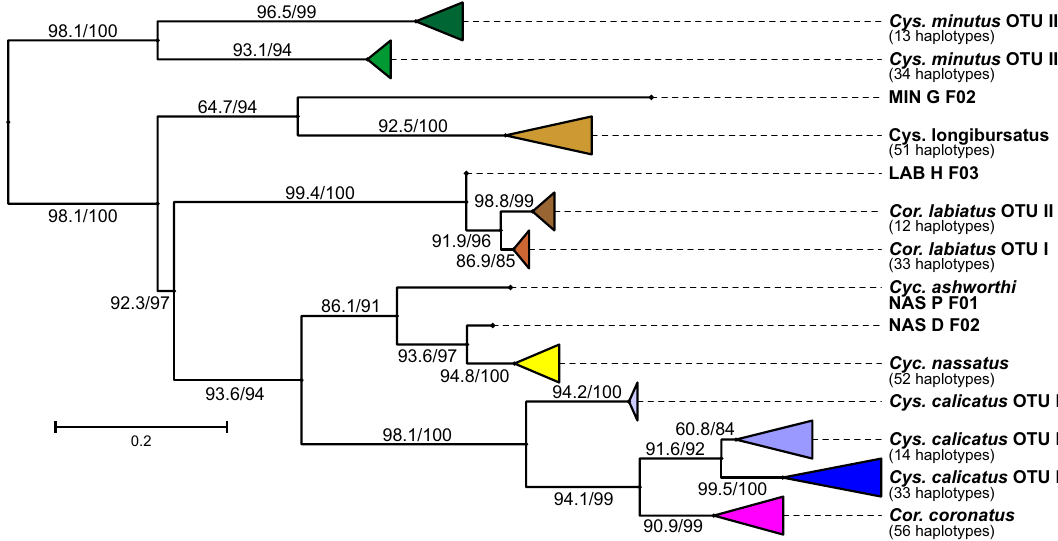
Figure 2. Maximum likelihood phylogenetic condensed tree calculated using aligned cytochrome oxidase 1. The scale bar represents 0.2 substitutions per site and node support was obtained by ultrafast bootstrapping (1000 replicates) after and the Shimodaira-Hasegawa likelihood ratio test before the slash. Individual specimens that were not assigned to one of the major clades are designated according to the following code: MIN, NAS, LAB for the species Cylicostephanus minutus , Cylicocyclus nassatus , Coronocyclus labiatus , respectively; G, H, P, K, D, Z for the hosts German horse, Ukrainian horse, Przewalski’s horse, kulan, donkey and zebra, respectively; F/M for female or male; a number indicating the individual specimen. OTU, operational taxonomic unit.